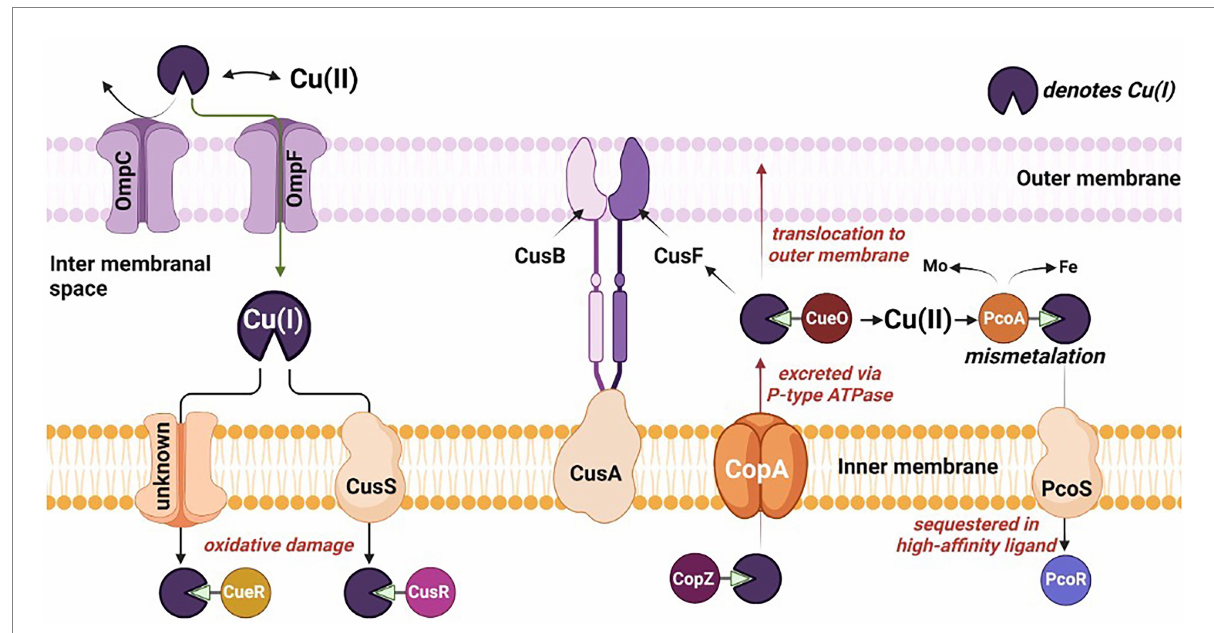
FIGURE 2 Mechanistic overview of the toxicity, sequestration, and translocation of copper in sulfate reducing bacteria. Omp, outermembrane protein; Cus, copper exporter protein; Cop, Cu + -ATPase protein; and Pco, periplasmic copper binding